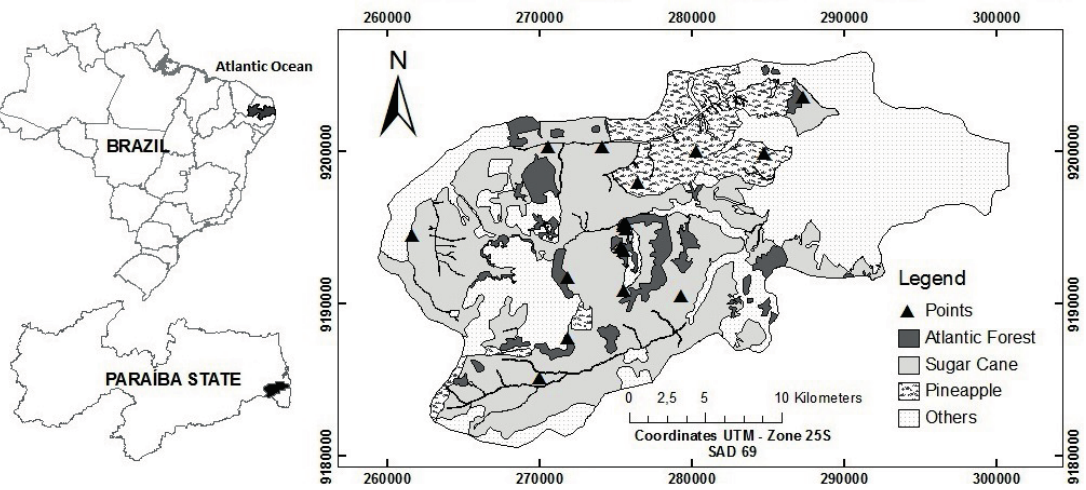
Fig. 1 Study area location (Gramame River basin) and infiltration test points .